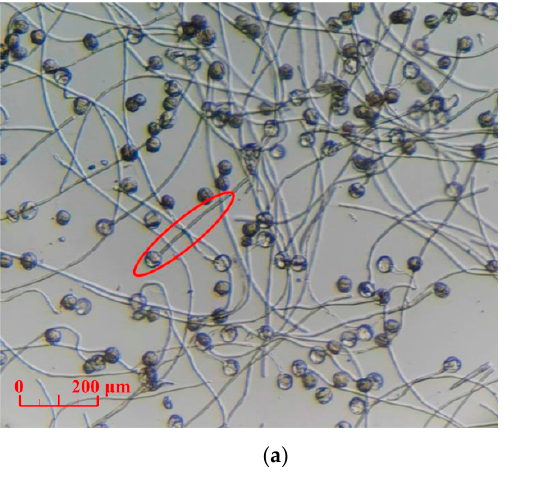
Figure 1. Two different states of pollen grains. The magnification of the picture is 50 times. The germinated pollen was marked by a red oval, which was characterized by the length of the pollen tube being significantly larger than the diameter of the pollen grains. ( b ) was non-germinated pollen, which is characterized by no pollen tube. ( a ) Germinated pollen grains. ( b ) Non-germinated pollen grains.